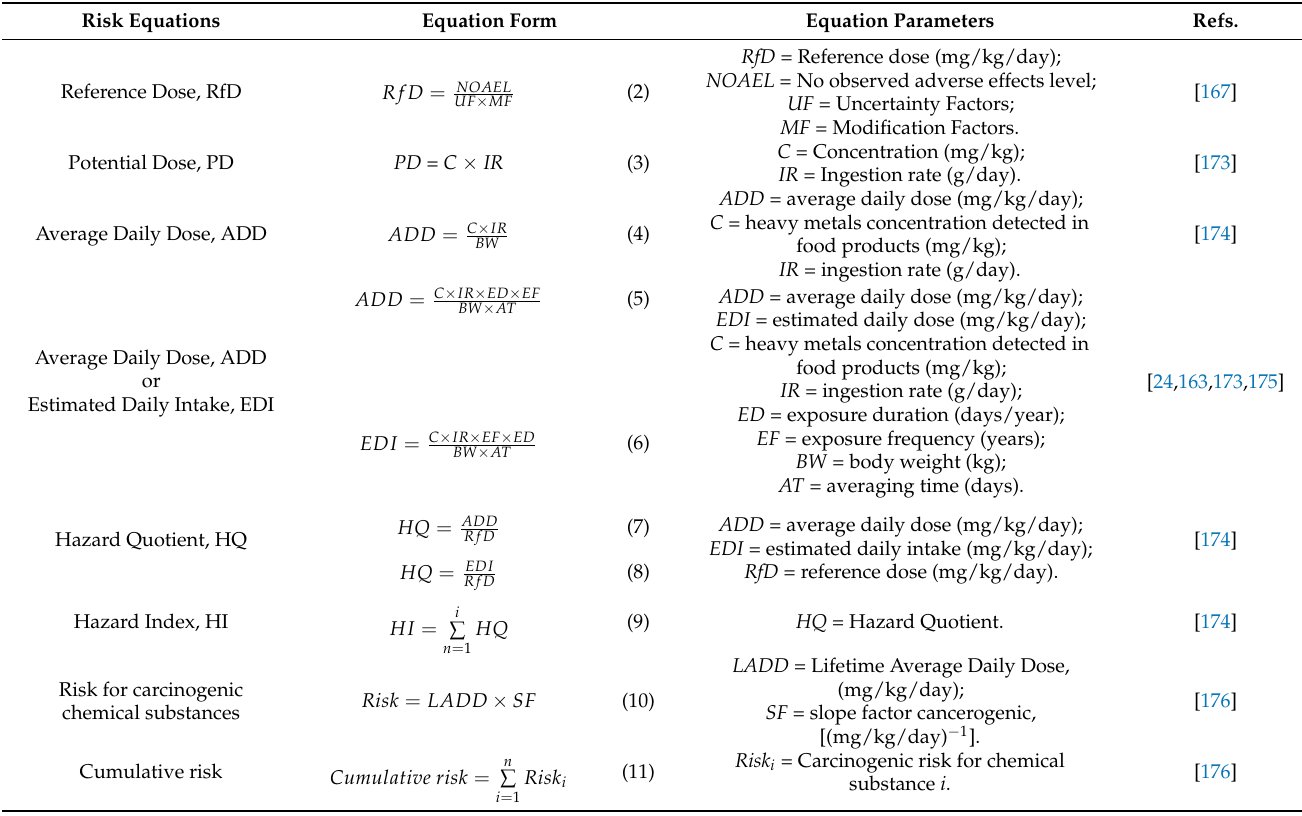
Table 3. Equations used in risk assessments of heavy metals in food products.